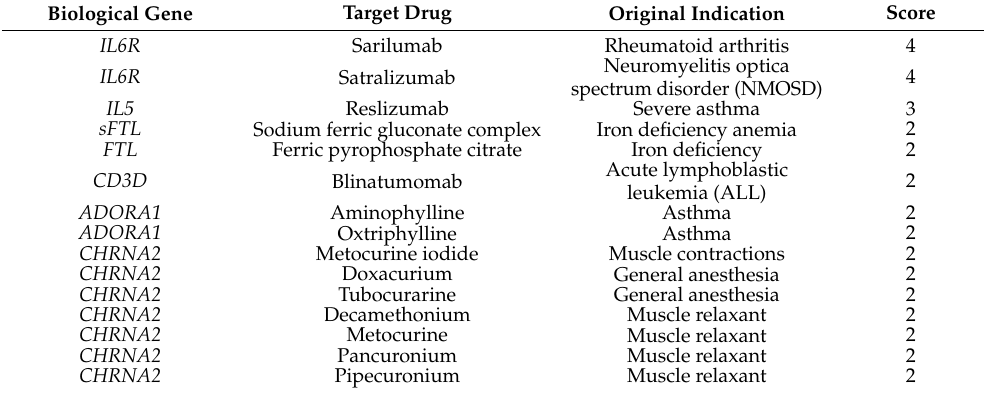
Table 3. Drug repurposing candidates for depression identified using a genomic-analysis-based